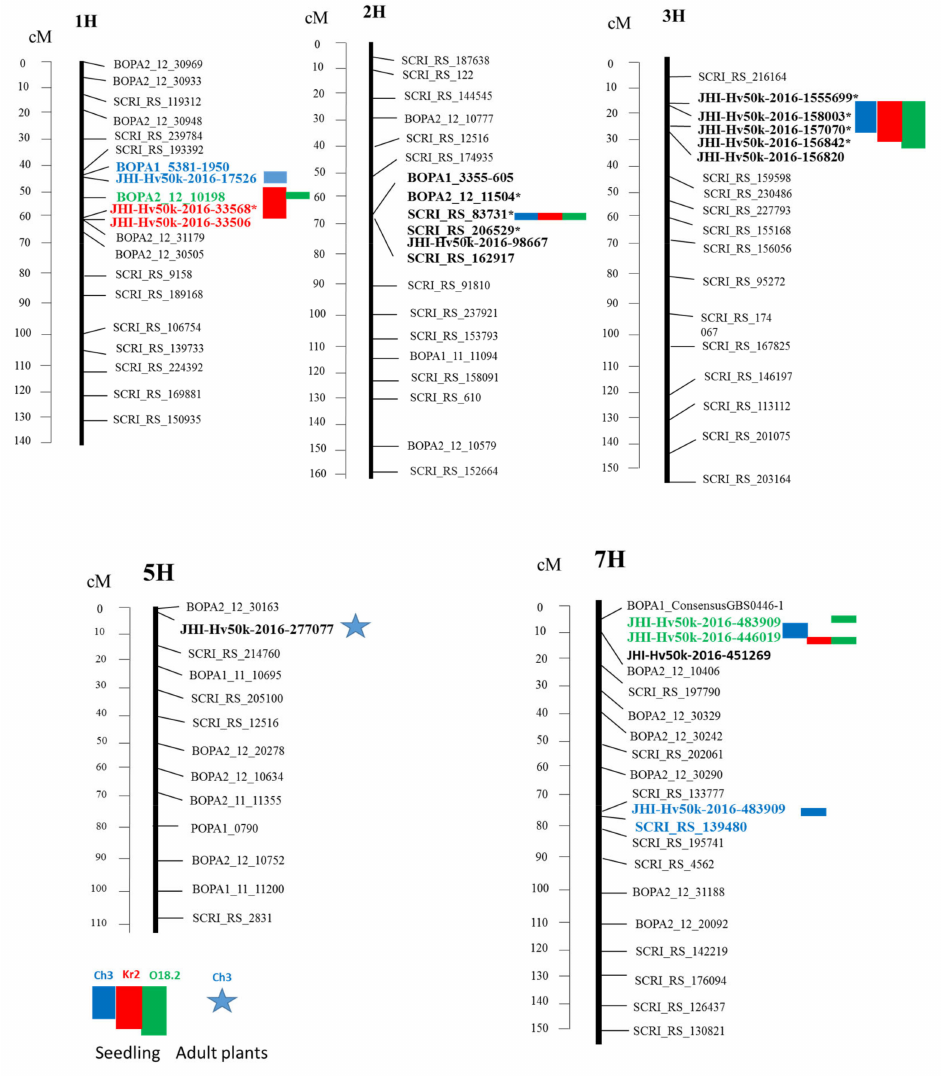
Figure 1. Location of genome fragments on five chromosomes (1H, 2H, 3H, 5H and 7H) associated with resistance to spot blotch by testing di ff erent isolates: Kr2 (red), Ch3 (blue), and O18.2 (green); and di ff erent phases: seedling (rectangle) and adult plant (star). Black bold markers are markers found with all isolates. * markers were found in previous research (Bykova et al.,